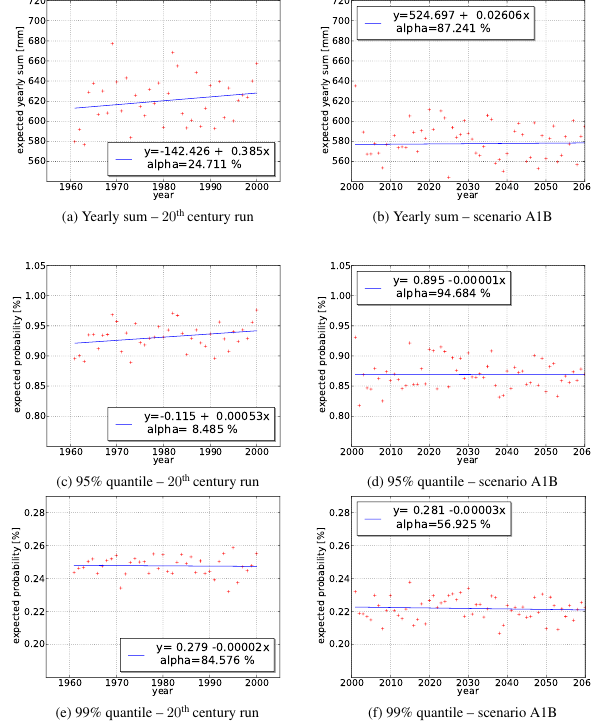
Fig. 12. Linear trend during summer months in the expected precip- itation sum and the yearly probability of values exceeding the 95% and 99% quantile according to the CP-temperature sequence de- rived from ECHAM5; quantiles refer to the calibration period from 1991 to 2003.